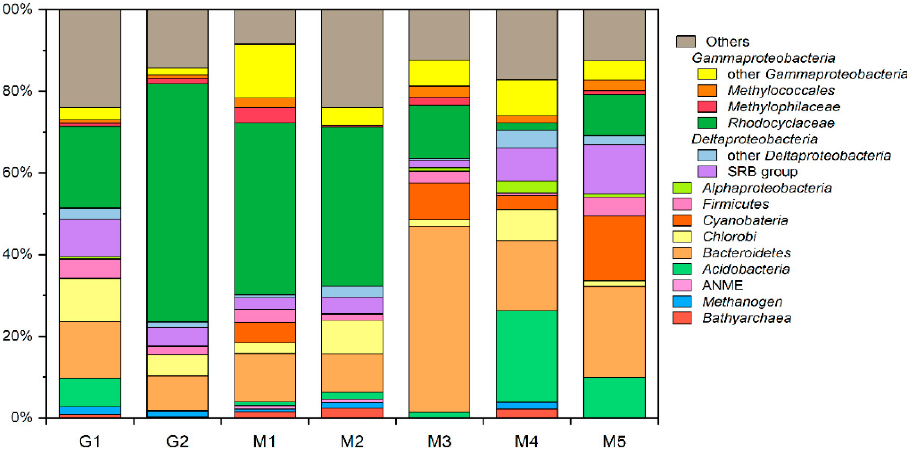
Figure 7. Relative abundance of community members in Gamou (‘G’) and Murono (‘M’)